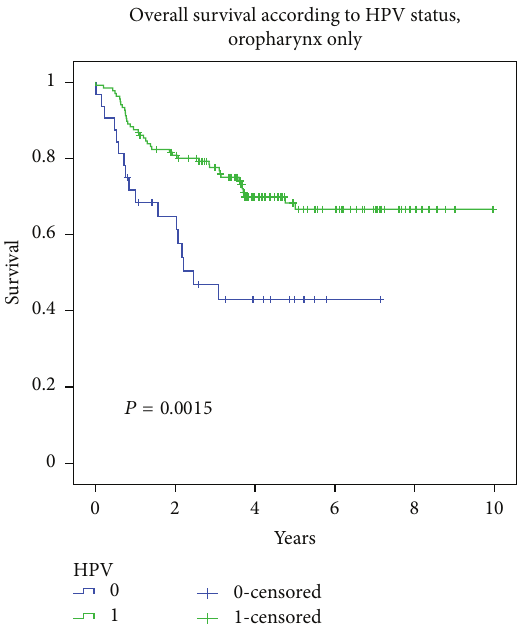
Figure 3: Overall survival for oropharyngeal primaries according to HPV status.